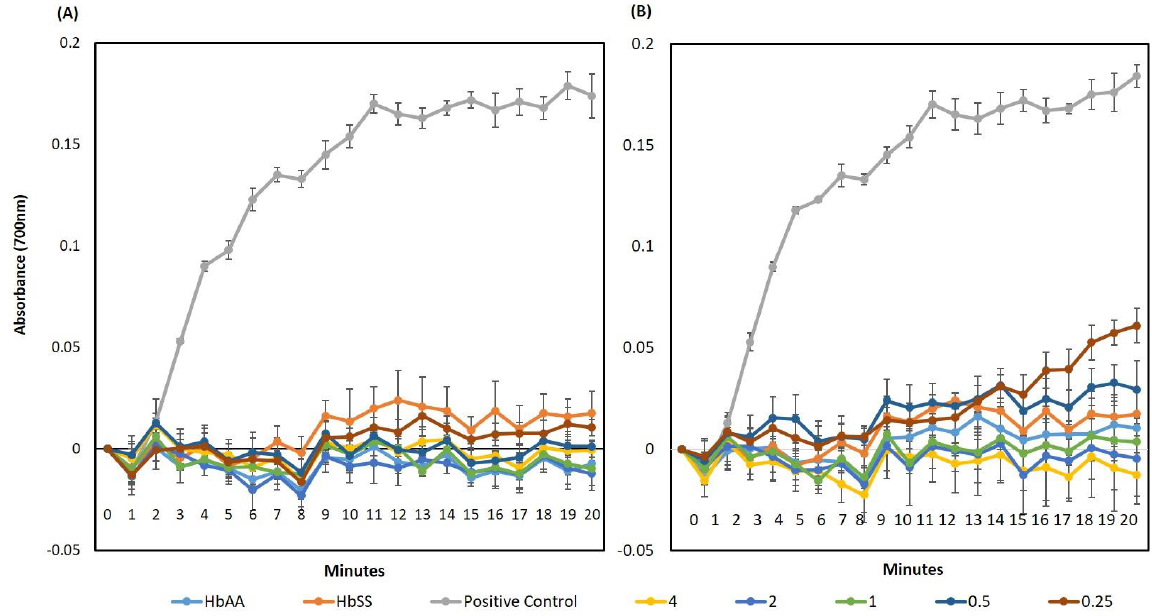
Figure 5. Inhibitory Effects of different concentrations of 0.25-4 mg/mL of ( A ) quercitrin and ( B ) p- hydroxybenzoic acid on HbS polymerisation, in vitro. Quercitrin inhibits HbS polymerisation com- pared to the “positive control”: deoxyHbS without quercitrin. With HbSS; HbS not subjected to de- oxygenation. DeoxyHbA (HbAA) did not polymerise and represents a negative control. This repre- sents data obtained from three typical independent experiments performed in quadruples.